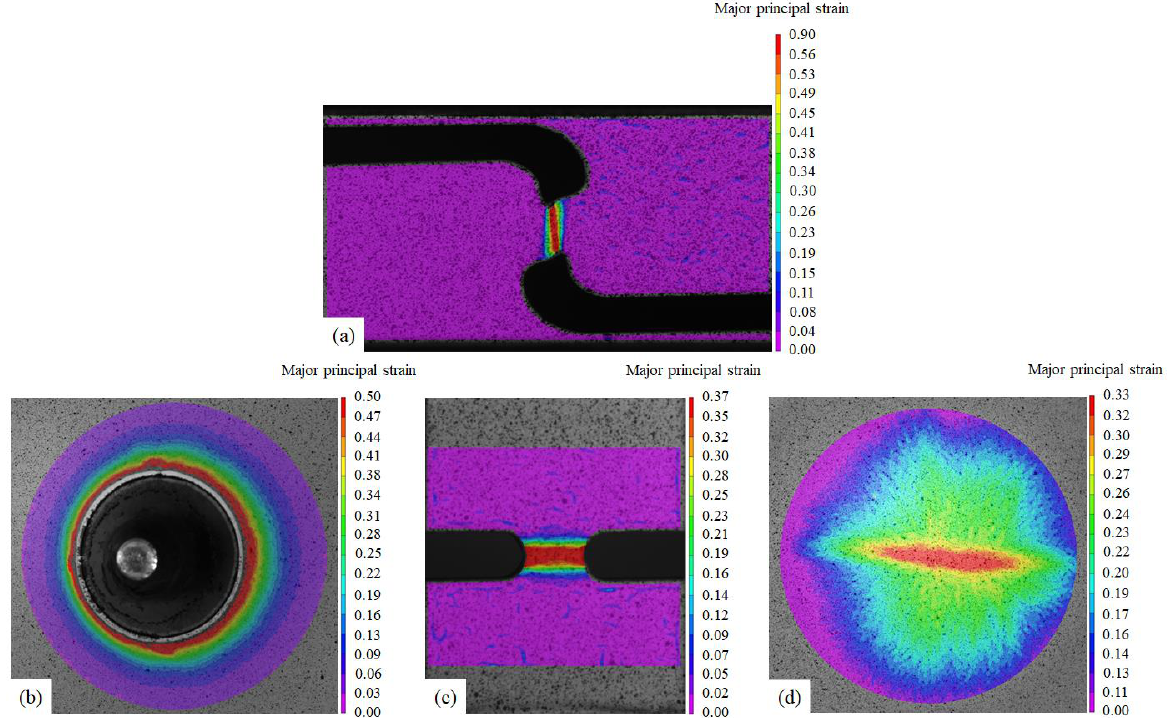
Figure 10. Major principal strain DIC contour plots at one frame prior to fracture for the ( a ) shear (350 ◦ C die-quenched condition), ( b ) hole-expansion (25 ◦ C die-quenched condition), ( c ) plane-strain notch tension (450 ◦ C die-quenched condition), and ( d ) Nakazima (25 ◦ C die-quenched condition) specimens of Ductibor ®